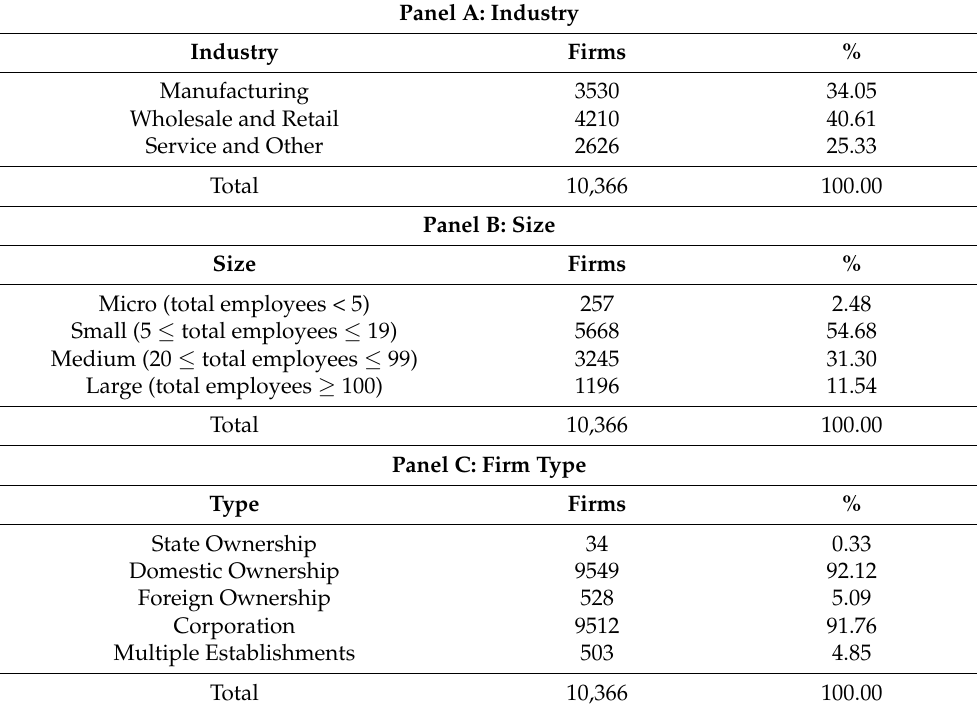
Table 1. Characteristics of